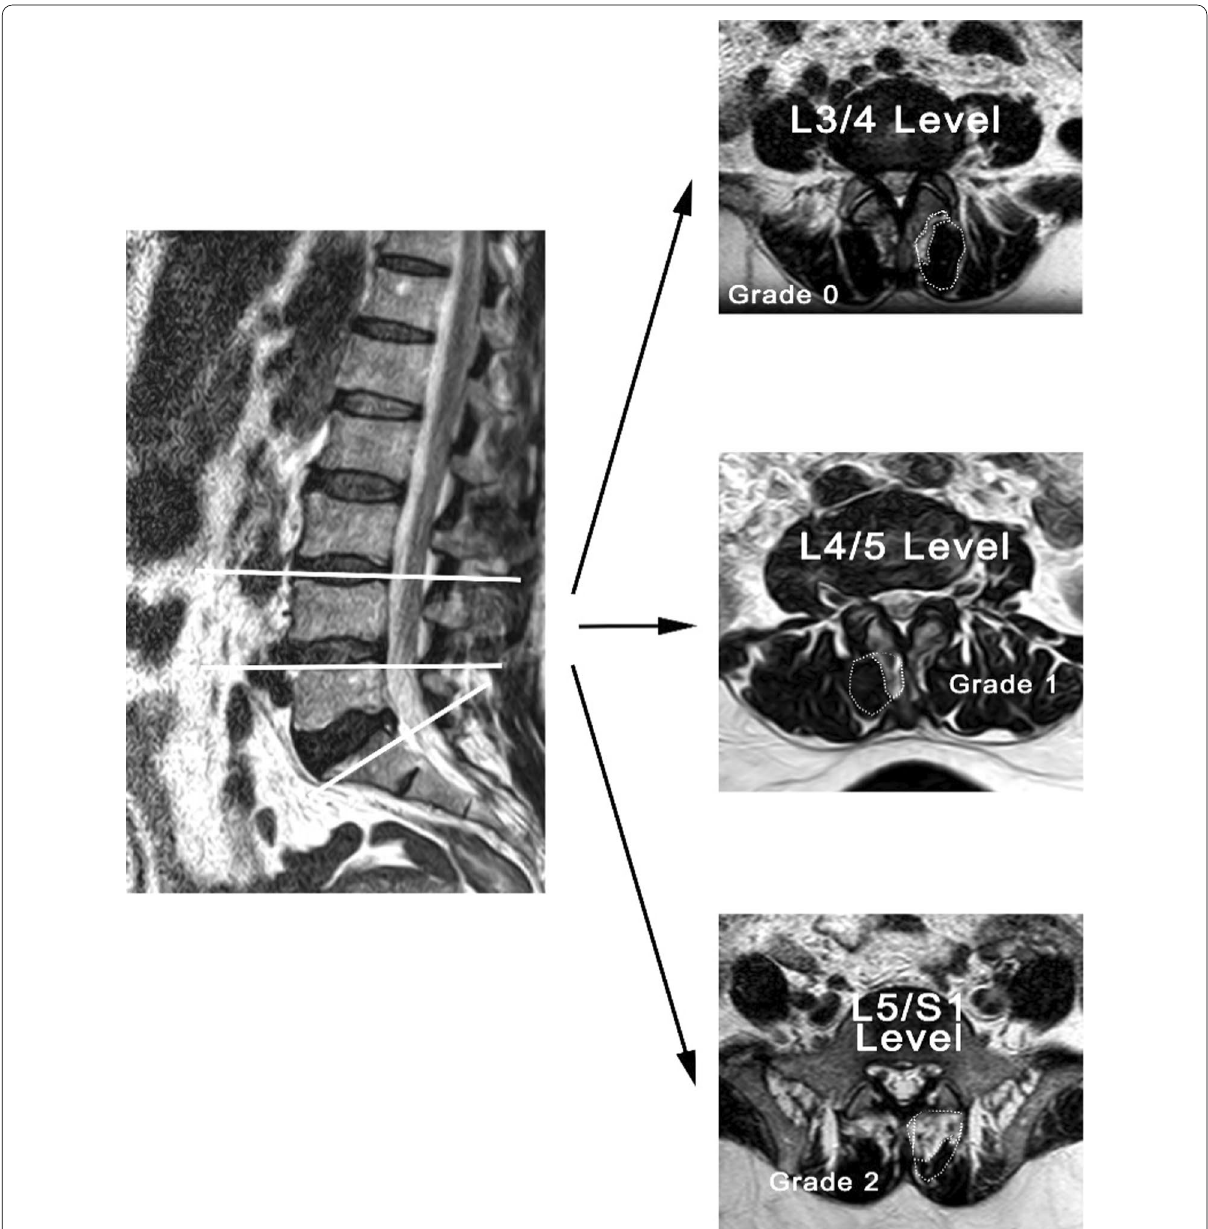
Fig. 1 Lumbosacral MRI, of a 28-year-old man with 3 years history of LBP without sciatica, BMI No neural canal stenosis. Average VAS score and grade 2 MS degeneration at L5/S1 level, MS to MS equation, the expected MS